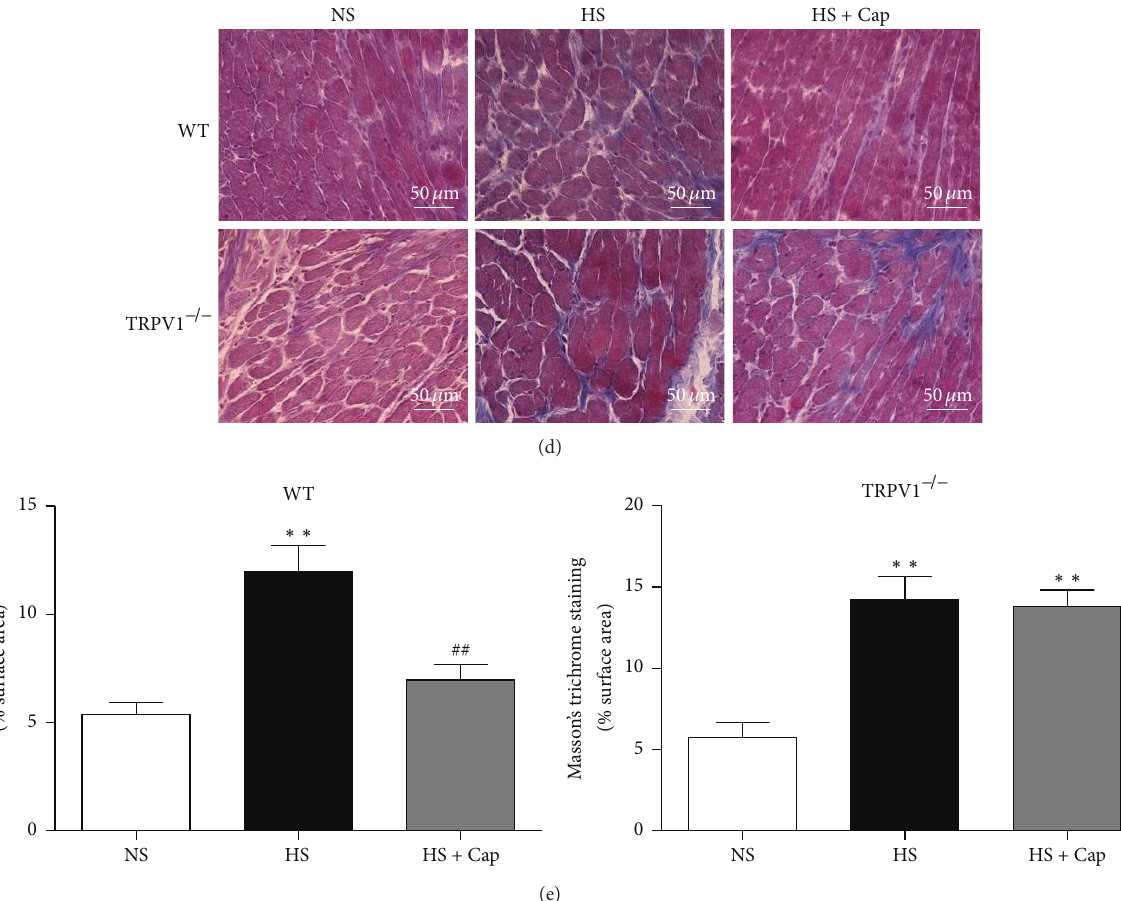
Figure3:DietarycapsaicinattenuatescardiachypertrophyandfibrosisinWTmiceonlong-termhigh-saltdietthroughTRPV1activation.(a) Photographs of sample hearts from WT and TRPV1 −/− on NS, HS, and HS + Cap group. (b) Heart weight index from various groups ( 𝑛 = 7 ). Mean ± SEM: ∗ 𝑃 < 0.05 versus NS; # 𝑃 < 0.05 versus HS. (c) Low-magnification view of hematoxylin and eosin stains of different group histological sections. (d) Masson’s trichrome staining for collage deposition of histological sections from various groups. (e) Quantification of interstitial fibrotic area. Values were expressed as the mean ± SEM from 7 separate experiments. ∗∗ 𝑃 < 0.01 versus NS; ## 𝑃 < 0.01 versus